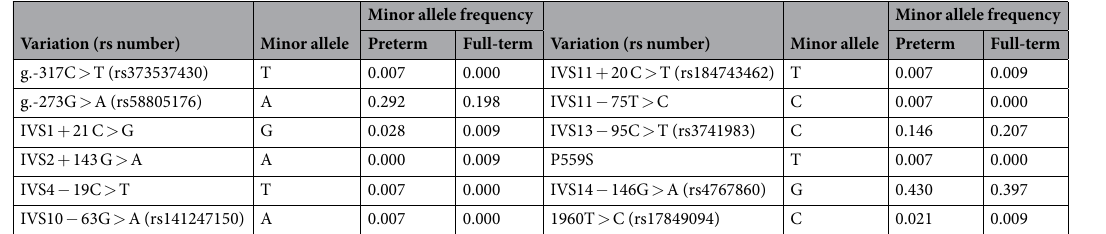
Table 2. Frequency of SHP-2 genetic variations in preterm or full-term infants. Data was obtained from DNA samples from 72 preterm infants and 58 full-term infants. Nucleotide location numbers were assigned from the translational start site based on the SHP-2 mRNA sequence (GenBank accession number;